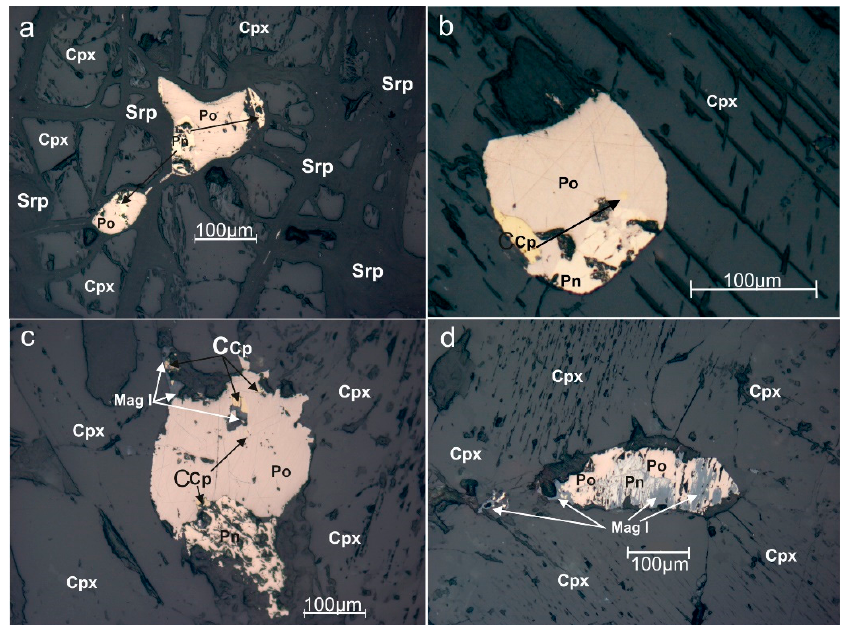
Figure 7. Backscatter electron images of chromian spinel in serpentinites of the Nizhne-Derbinsk (a,b sample 8/4) and Burlakski (c,d, sample 3/7) plutons. ( a ) Euhedral and subhedral crystals of chromite (Chr) adjacent to magnetite (Mag) within a matrix of serpentine (Srp). ( b ) Elemental map illustrating the distribution of Fe, Cr, and Mg among chromite, magnetite, and serpentine. ( c ) Rounded crystal of chromian spinel hosting an inclusion of olivine (Ol). ( d ) Anhedral crystal of chromian spinel hosting inclusions of pentlandite (Pn) and pyrrhotite (Po).